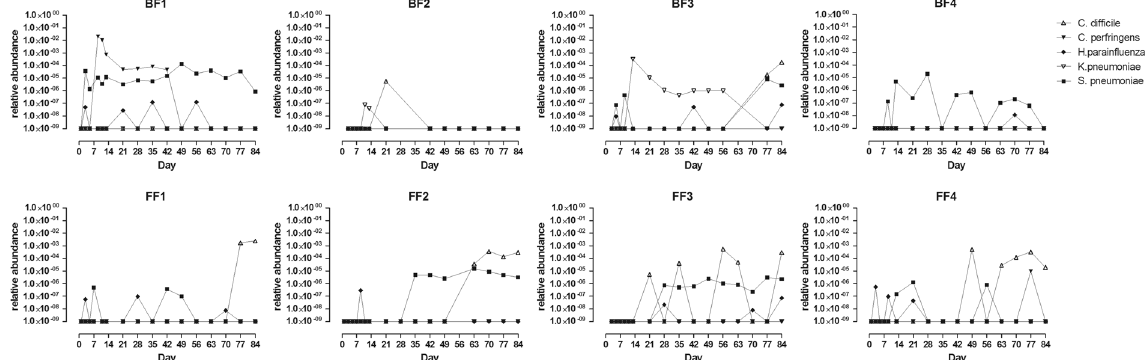
Figure 5. Relative abundance of potential pathogens of the oro-gastrointestinal and respiratory tract as detected by qPCR in the faeces of breastfed and formula-fed infants from day 1 till 12 weeks. Relative abundance was calculated as a fraction of the calculated copy numbers for total bacterial counts (16S universal primers) and targeted pathogens. The detection threshold for all qPCRs performed was considered to be 100 target copies of